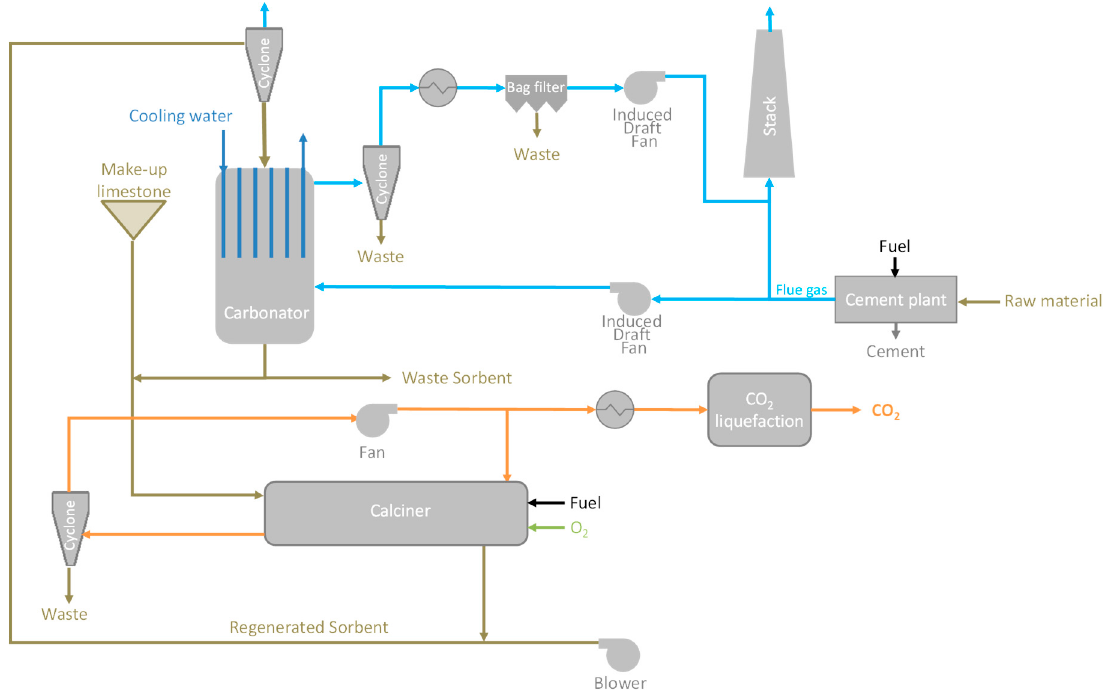
Figure 13. Set-up of the 1.9 MW th HECLOT pilot facility installed at Ho Ping cement plant in Taiwan (adapted from [66]).